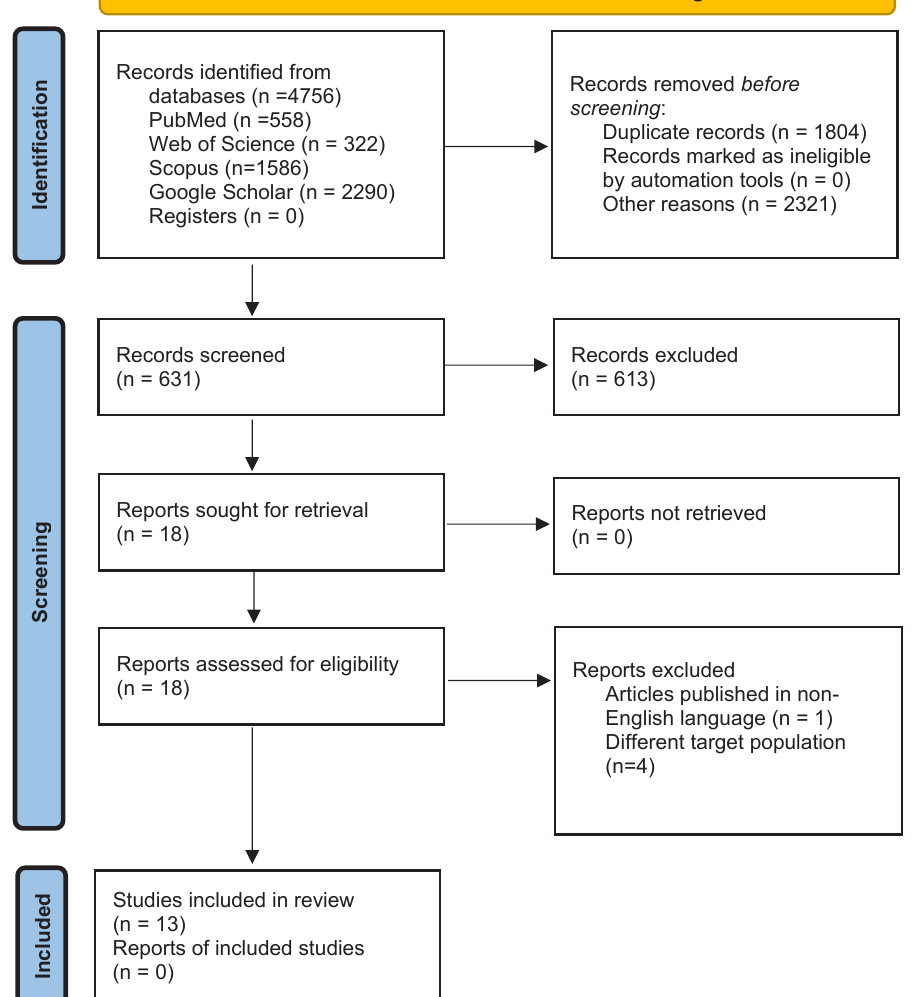
Figure 1. Flowchart of selection of studies for systematic